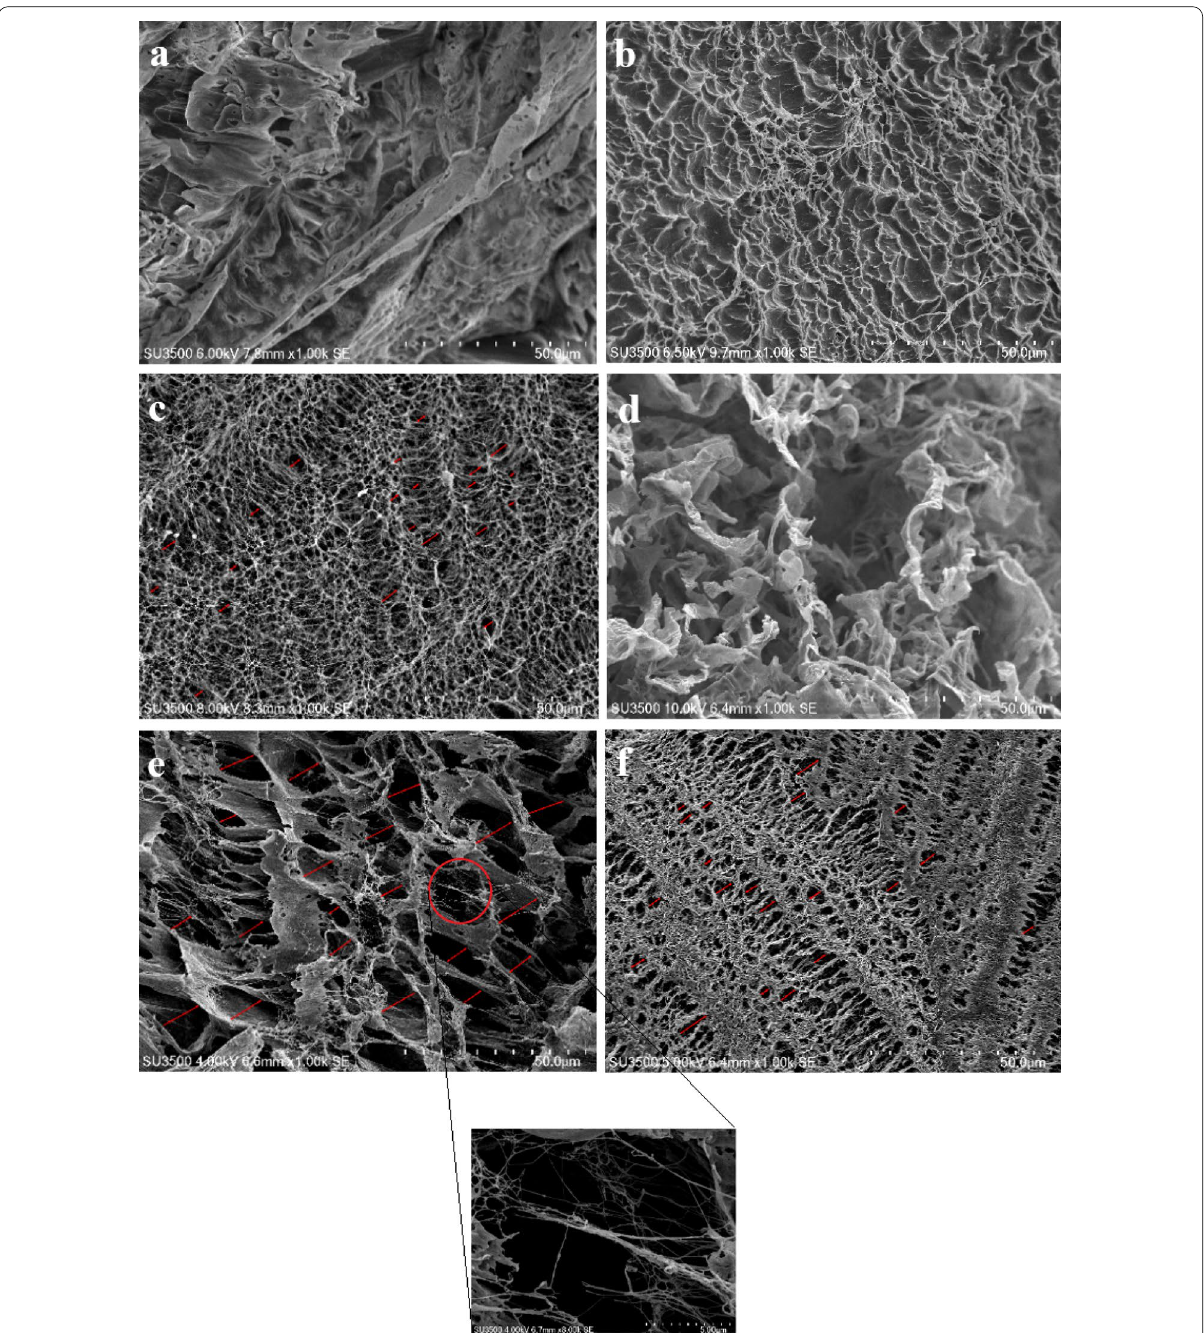
Fig. 6 Scanning electron microscopy images of the crosslinked hydrogels: a pure PVA, b – d 25/75, 50/50, and 75/25 CS/PVA-based hydrogels crosslinked at 25 kGy, respectively; e , f 50/50 CS/PVA-based hydrogel crosslinked at 10 and 30